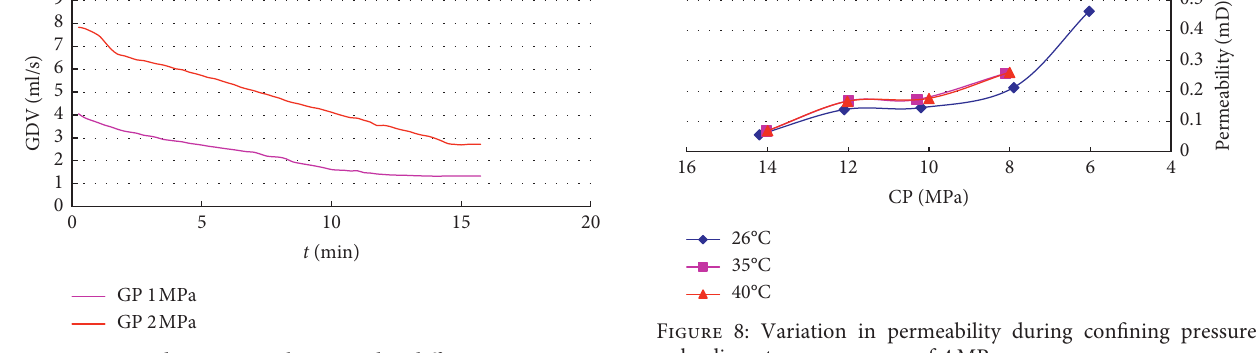
Figure 5: Gas desorption velocity under different gas pressure conditions.